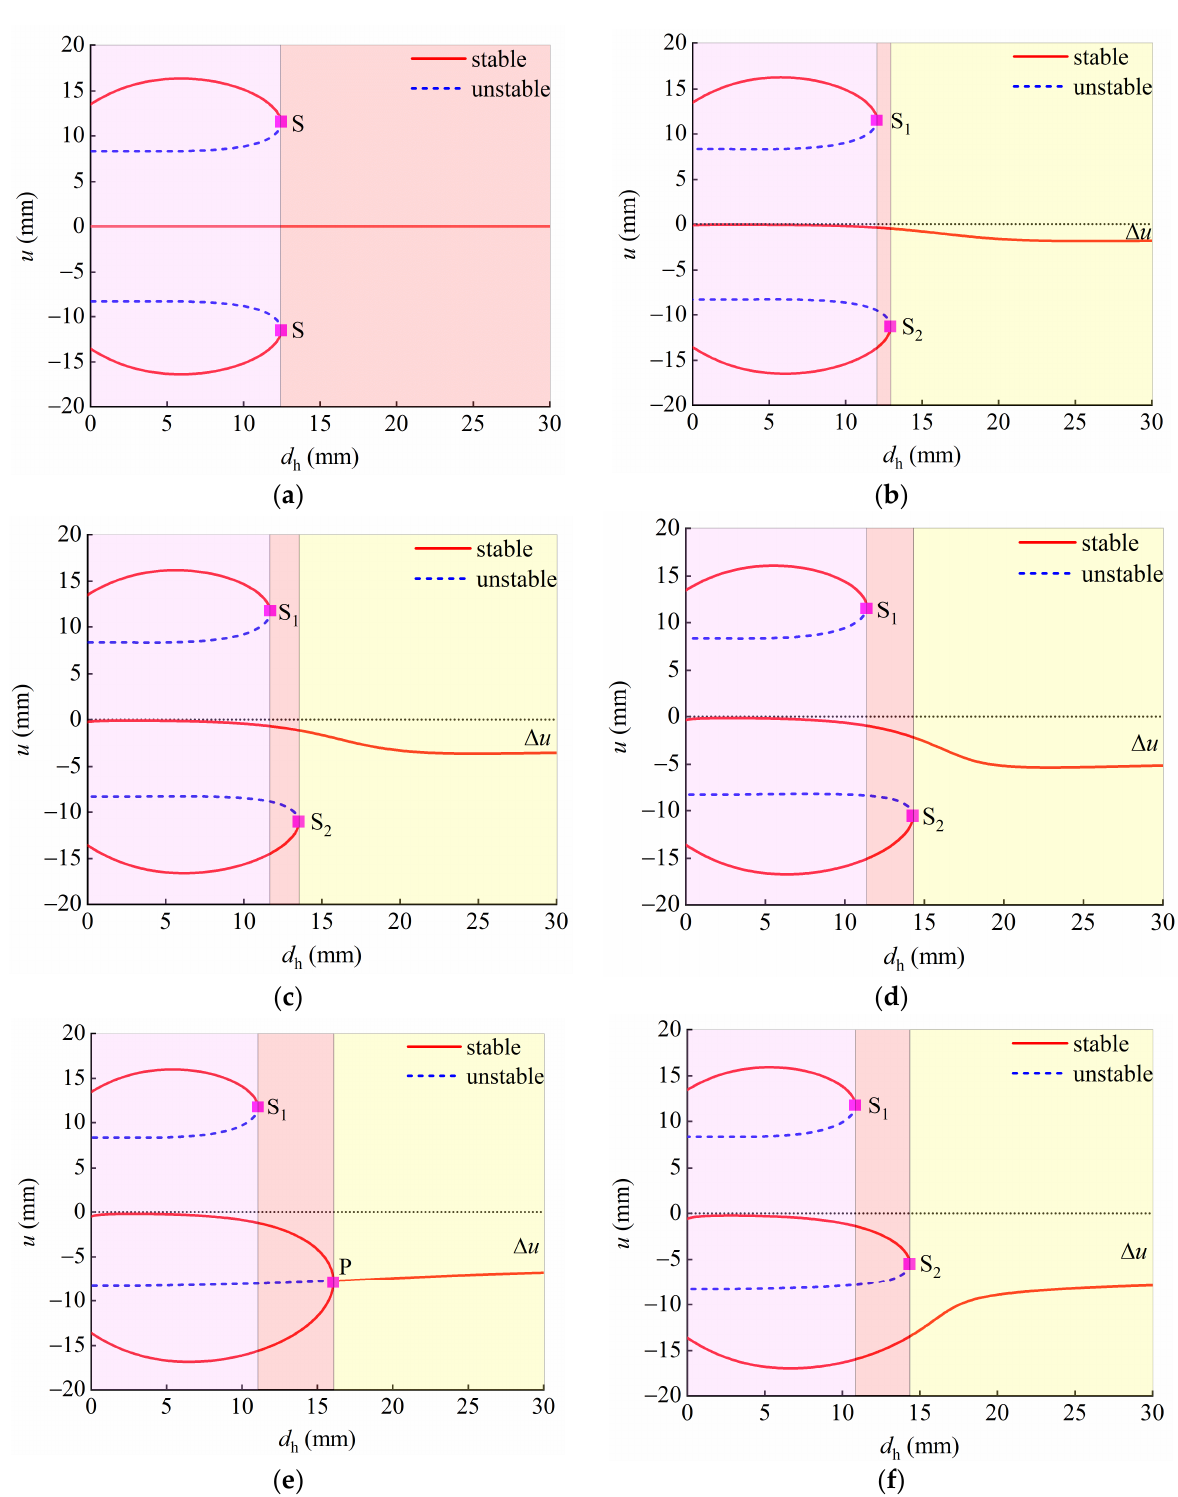
Figure 4. Bifurcation diagram of ( , ) with different end magnet masses : ( a ) = 0 g; ( b ) = 3 g; ( c ) = 6 g; ( d ) = 9 g; ( e ) = 12 g; ( f ) = 15 g.